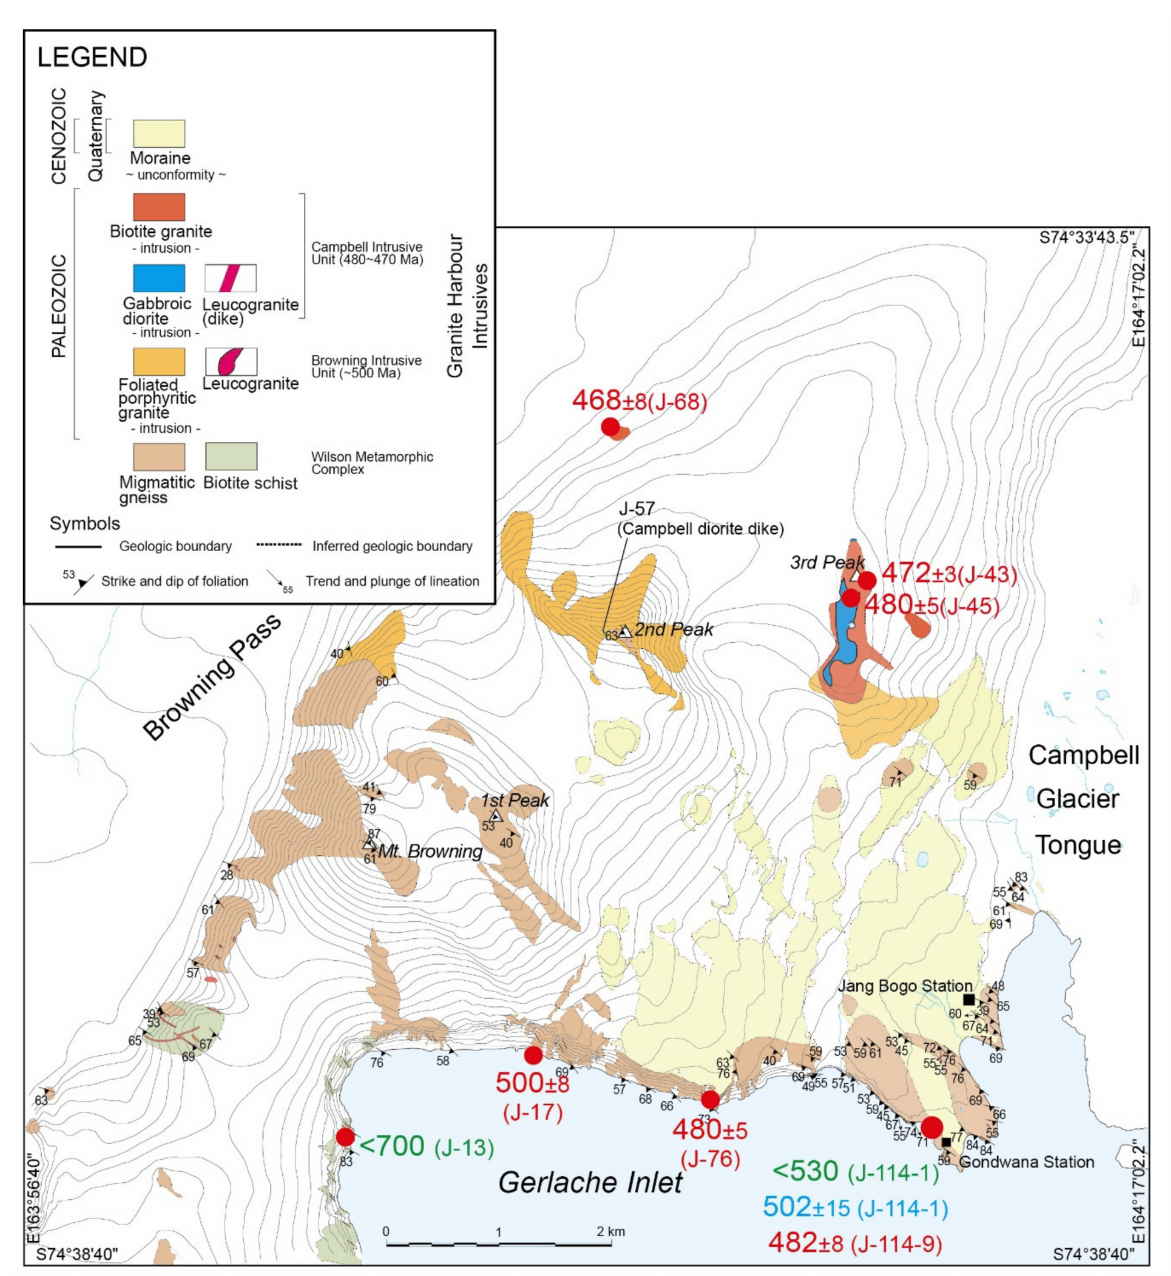
Figure 1. Geologic map of the study area (modified from [15]) showing zircon U-Pb ages (in Ma) obtained in the present study and the associated sample numbers. Values in green, blue, and red denote deposition, metamorphic, and igneous ages,